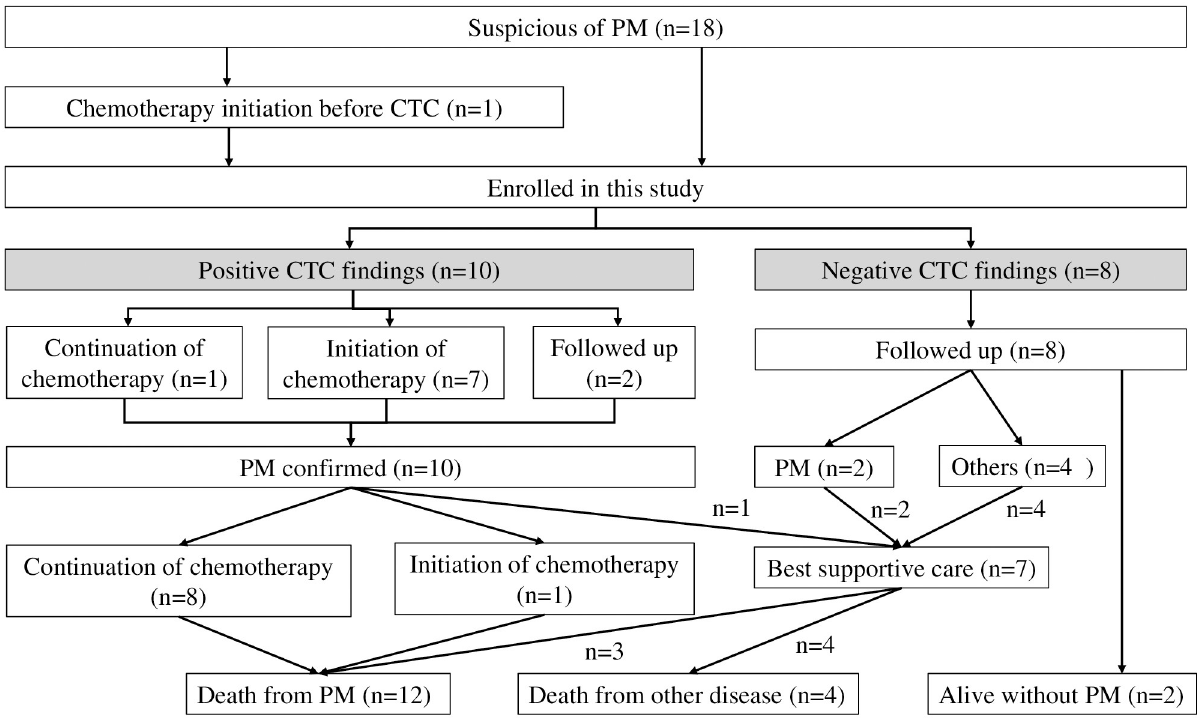
Fig 3. A flow diagram showing the treatment strategy for the 18 patients who underwent computed tomography colonography (CTC).